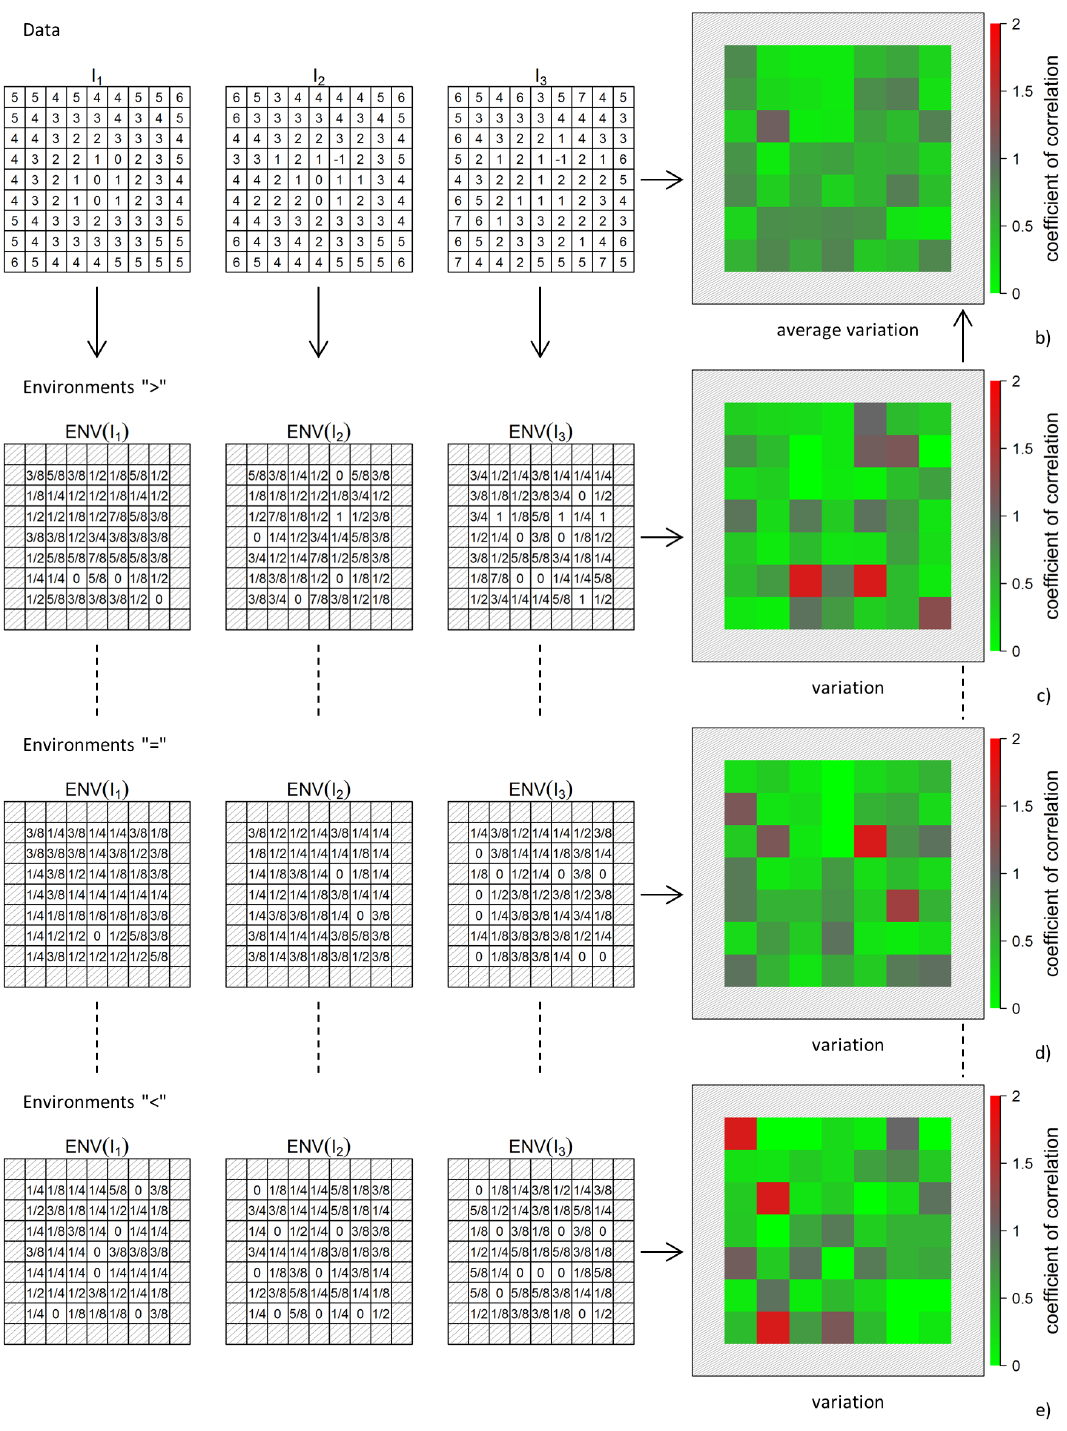
Figure 5b. Subfigures (b–e) illustrate the procedure from data set ( b ; left) to the environment measures ( c–e ; left), to the coefficients of variation for different environments ( c–e ; right) and to the final describing average pattern ( b ; right).